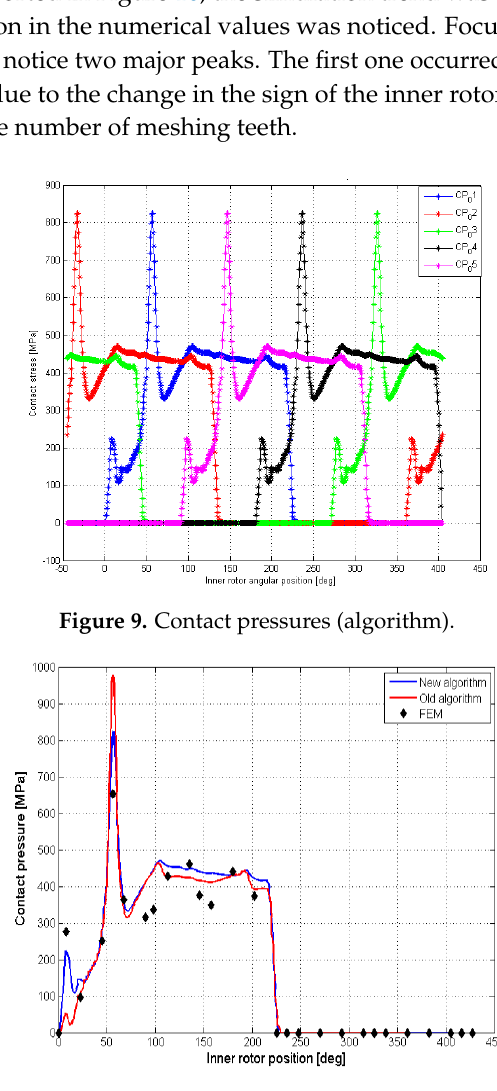
Figure 10. Contact pressures: algorithm vs FEM.